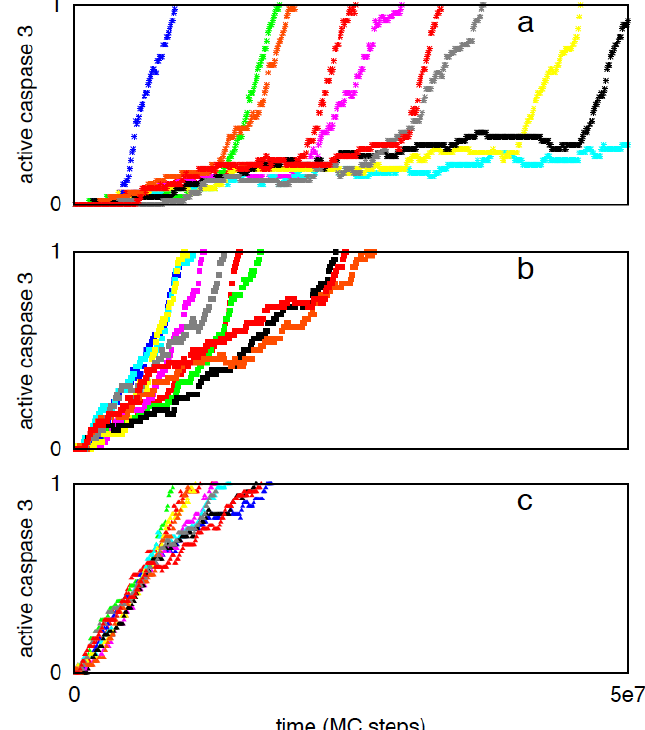
Figure 2. Caspase 3 activation for three different caspase 8 concentrations: 1 nM ( a ), 5 nM ( b ), 10 nM ( c ). Data is shown for 10 representative single cell runs; each color corresponds to apoptosis activation for a single cell (Monte Carlo run). Type 2 activation is characterized by all-or-none type behavior with large cell-to-cell variability. Increasing concentration of caspase 8 results in increased type 1 activation and suppression of cell-to-cell